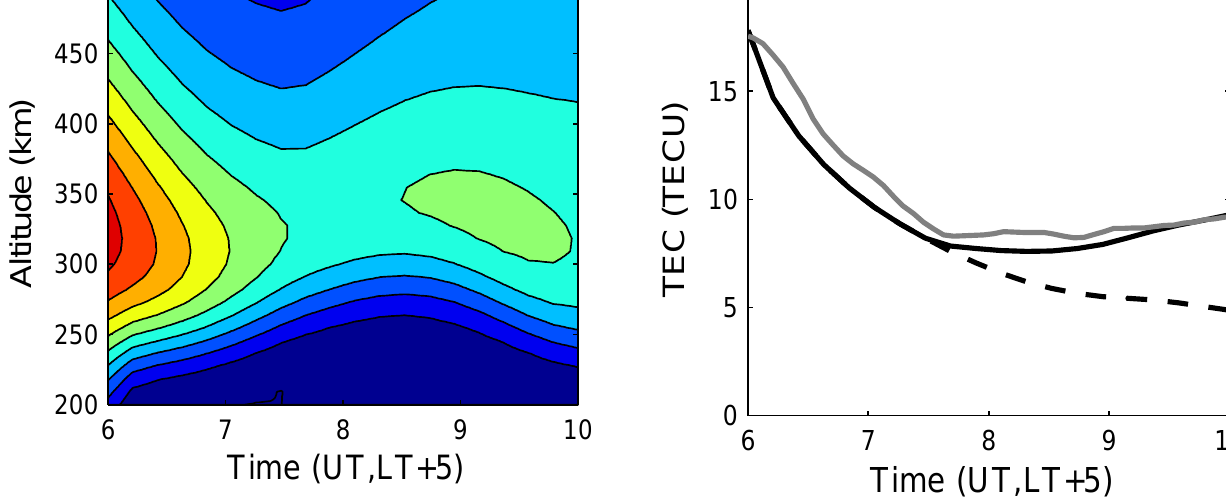
Fig. 12. Total electron content (TEC) from 200 to 450km for the simulation results presented in Fig. 10 (dashed black) without flux, the simulation results presented in Fig. 11 (solid black) with flux, and the data